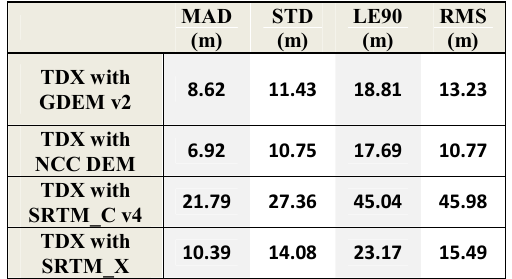
Table 3: Statistical parameters calculated for TanDEM-X DEMs